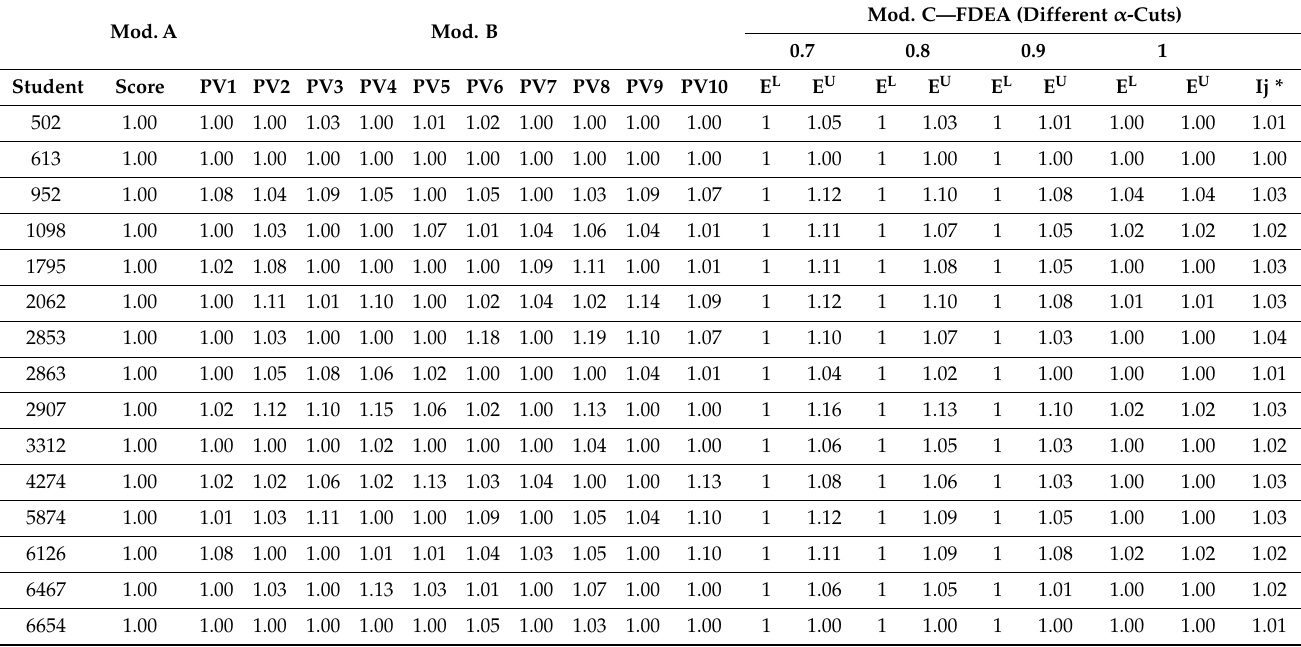
Table 7. Efficient units according to the traditional DEA compared to efficiency scores with other alternatives (FDEA and each